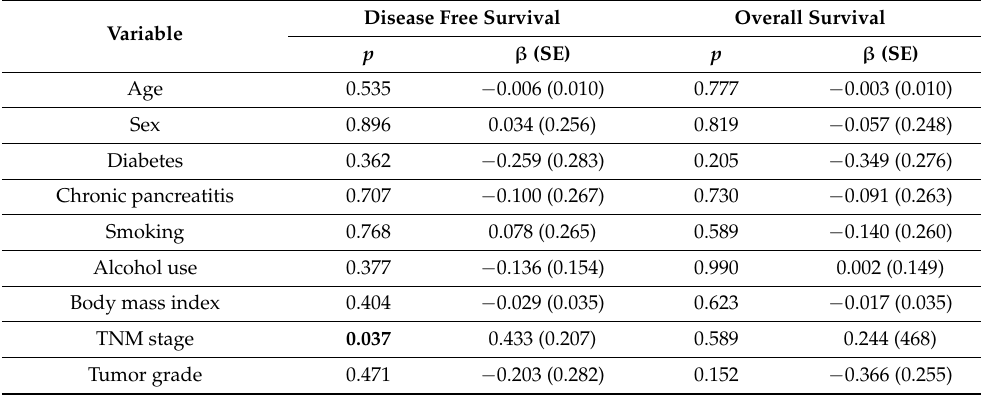
Table 3. Univariate Cox proportional hazards regression survival